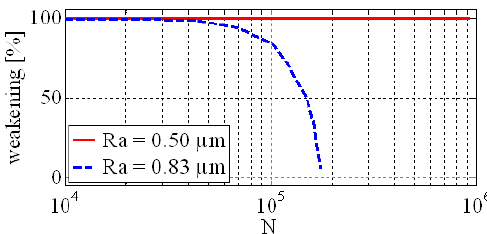
Figure 11. Performance degradation with a growing number of cy- cles for the different qualities of the notch surfaces ( L = 60mm, at